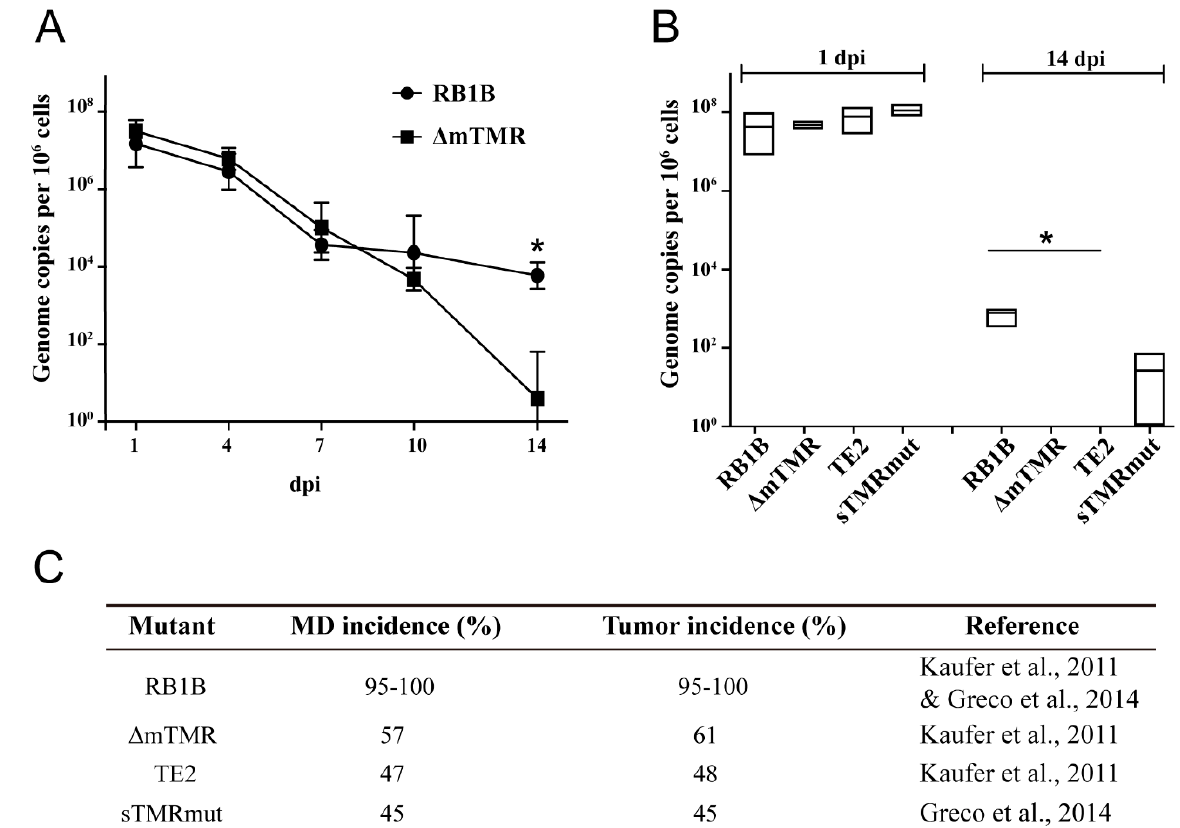
Figure 2. Genome maintenance of wt and mutant viruses in CU91 cells. ( A ) Monitoring viral genome copies in infected CU91 T cells over time with indicated viruses. Mean viral genome copies per million cells of 3 independent experiments are shown (* p < 0.05, Mann–Whitney U test). ( B ) Viral genome maintenance after CU91 T cell infections with indicated viruses were compared. Mean viral genome copies per million cells are shown as a box with the minimum and maximum. The asterisk indicates significant differences compared to RB1B (* p < 0.05, Kruskal–Wallis test, n = 3). ( C ) In vivo data previously published for the wt and TMR mutant viruses with respective references [12,24]. MD = Marek’s disease.